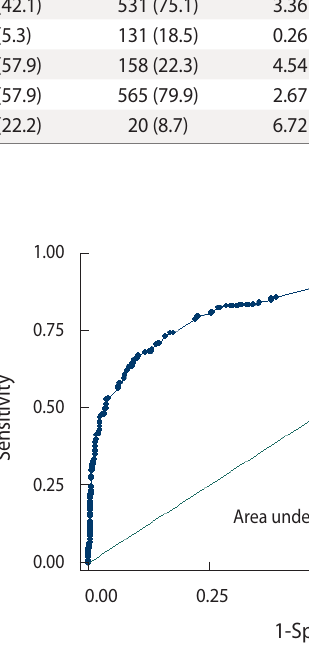
Figure 1. Evaluation of the multiple logistic regression model through the area under the receiver operating characteristic (ROC) curve.